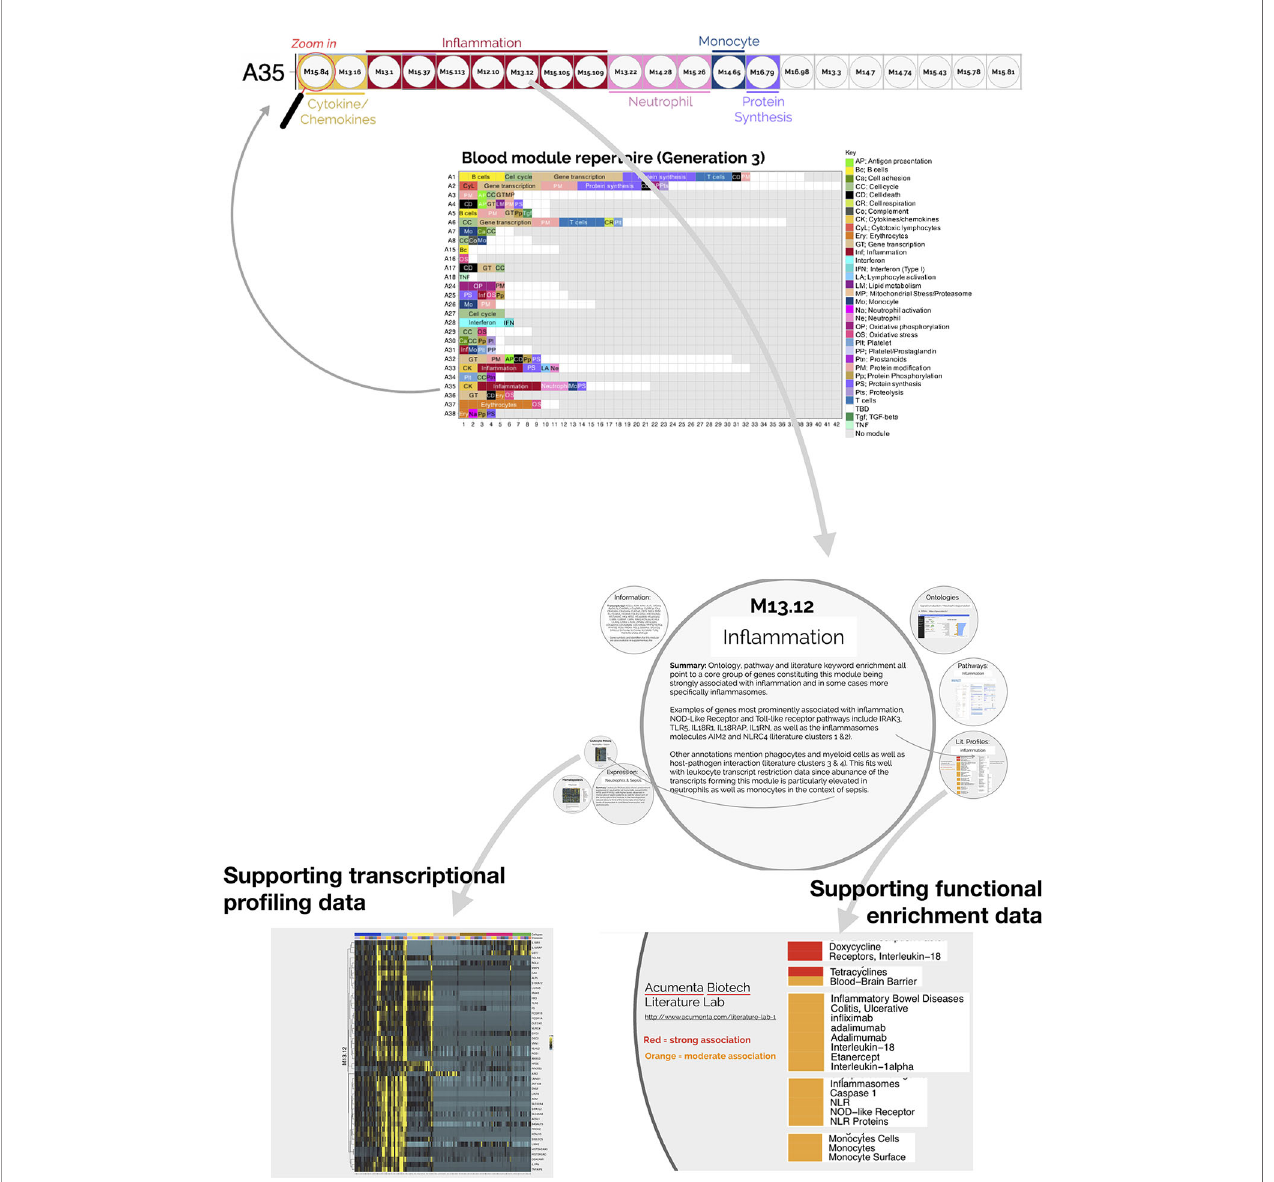
FIGURE 2 | Interactive presentation providing transcriptional pro fi ling and functional enrichment data for modules constituting aggregate A35. An interactive presentation has been developed that allows for exploration of the modules constituting aggregate A35. A gene list is provided for each module, along with gene ontology, pathway or literature term enrichment results and transcriptional pro fi ling data for the reference transcriptome datasets (circulating leukocyte populations, hematopoiesis). A summary of the fi ndings is also given. The interactive presentation is available via : https://prezi.com/view/7Q20FyW6Hrs5NjMaTUyW/. The presentation provides zoom in/out functionalities for close-up examination of the text and fi gures embedded in the